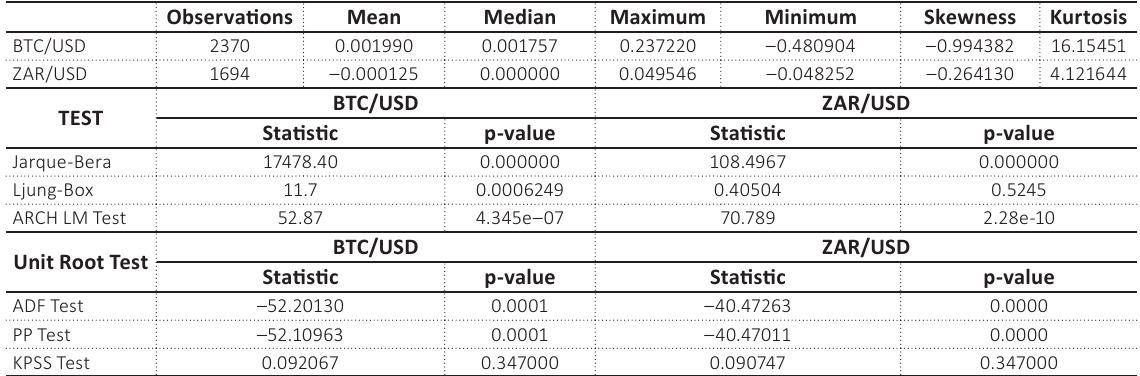
Table 1. Descriptive statistics of exchange rate